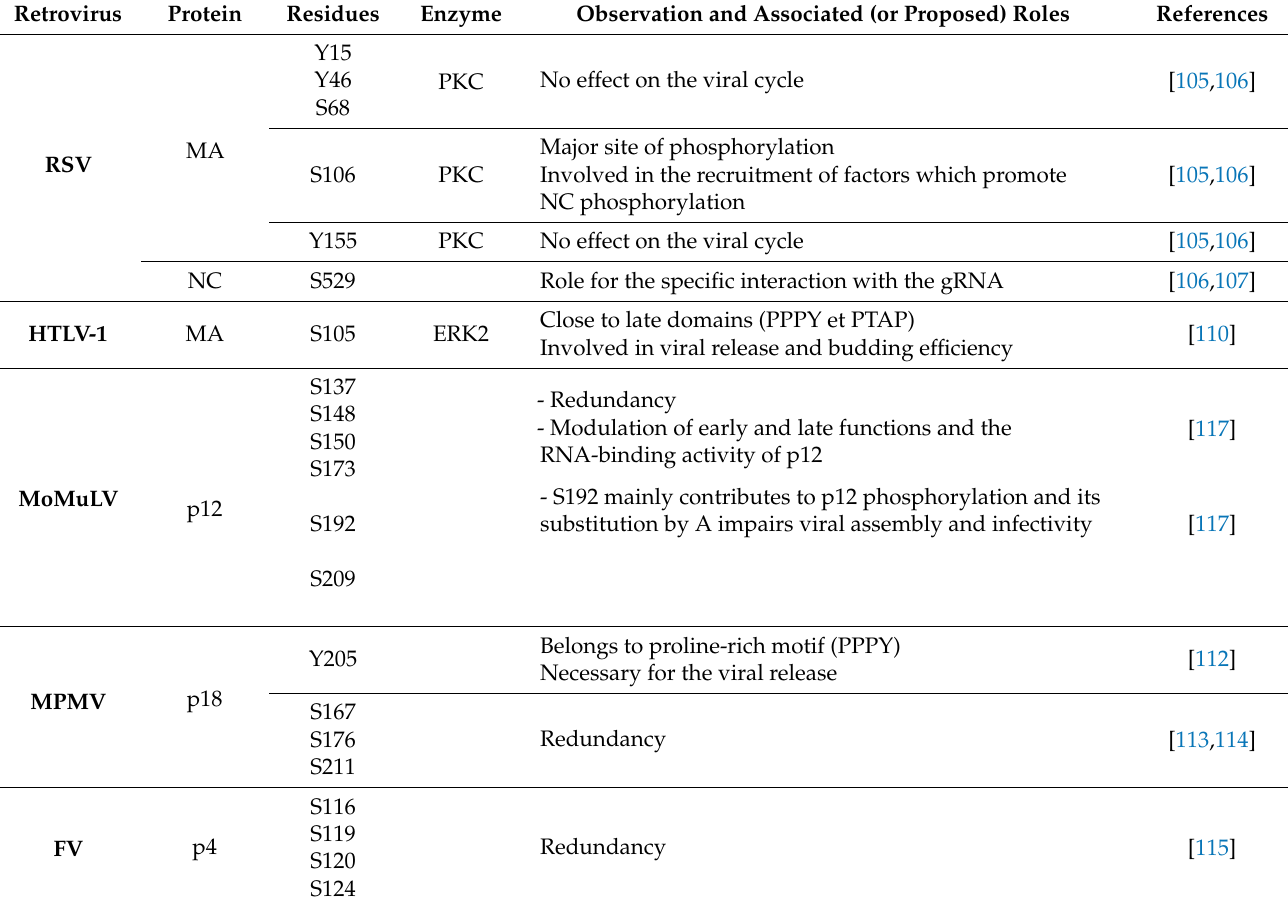
Table 2. Summary of phosphorylated positions in the different domains of retroviral Gag